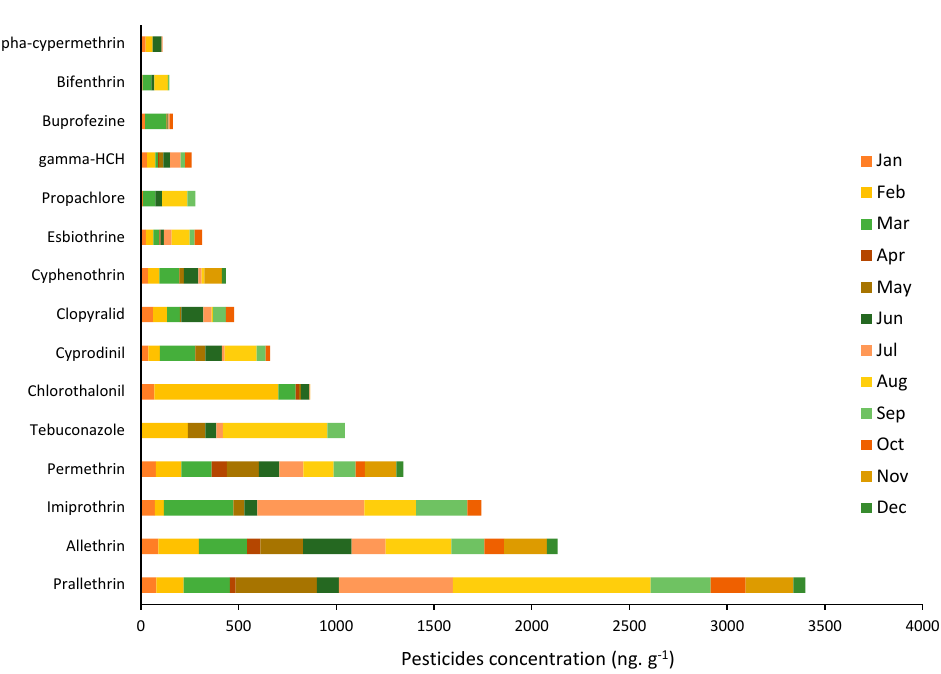
Figure 2. Monthly average concentrations of 15 pesticides detected in dust samples in the nine res- idences from 2016 − 2017 (data are shown as per average concentrations of pesticides detected in the nine residences per month) .